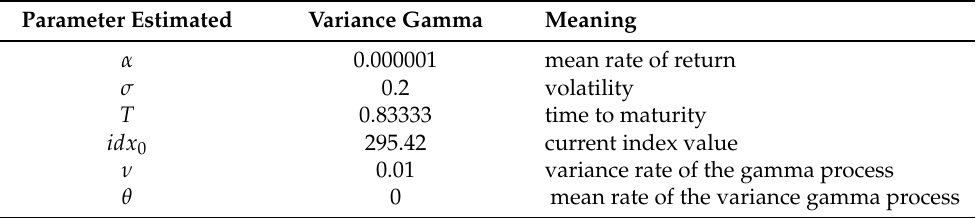
Table 2. The statistical density parameters on variance gamma